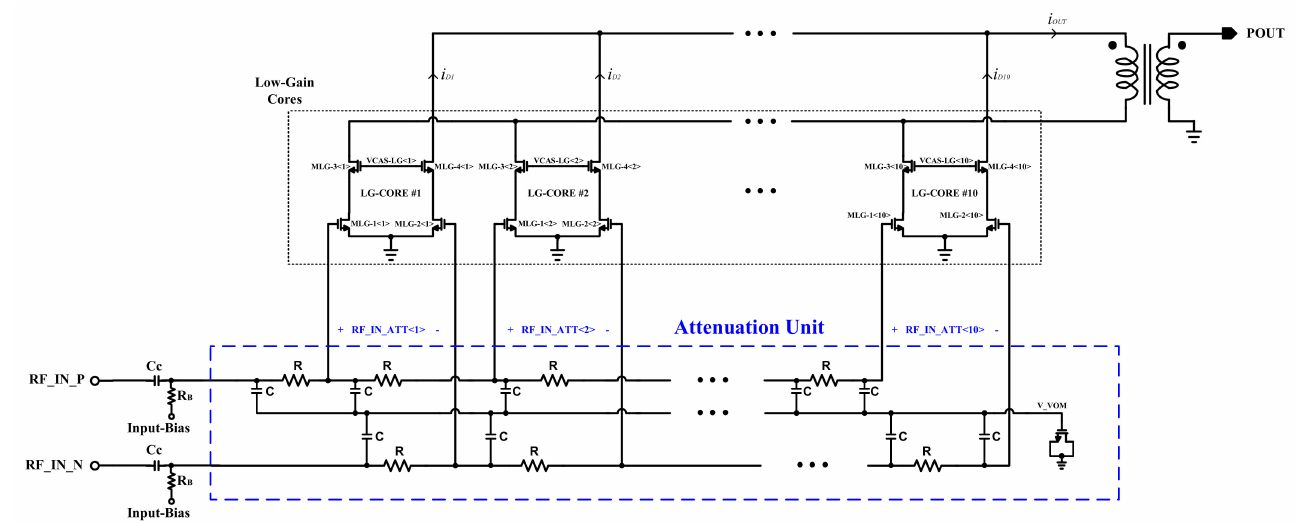
Figure 3. The proposed attenuation and power combining path of the